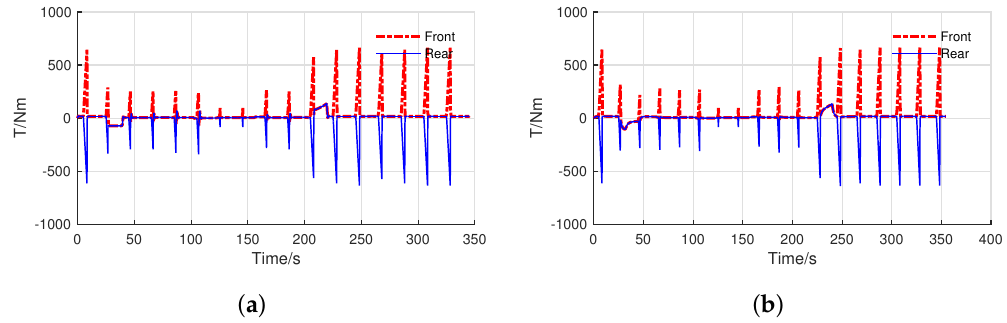
Figure 26. Drive torques of vehicles controlled by different controllers: ( a ) Controller A + ISPFCE and ( b ) Controller B + ISPFCE.